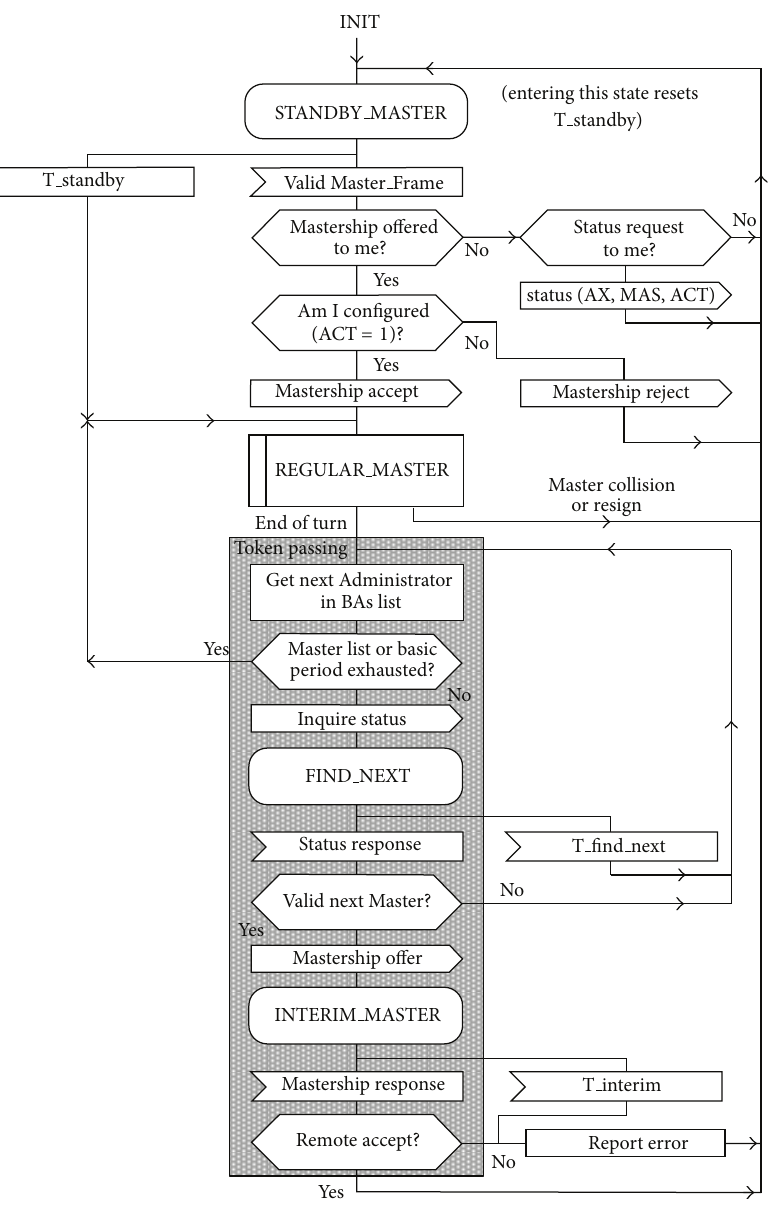
Figure 4: Mastership Transfer